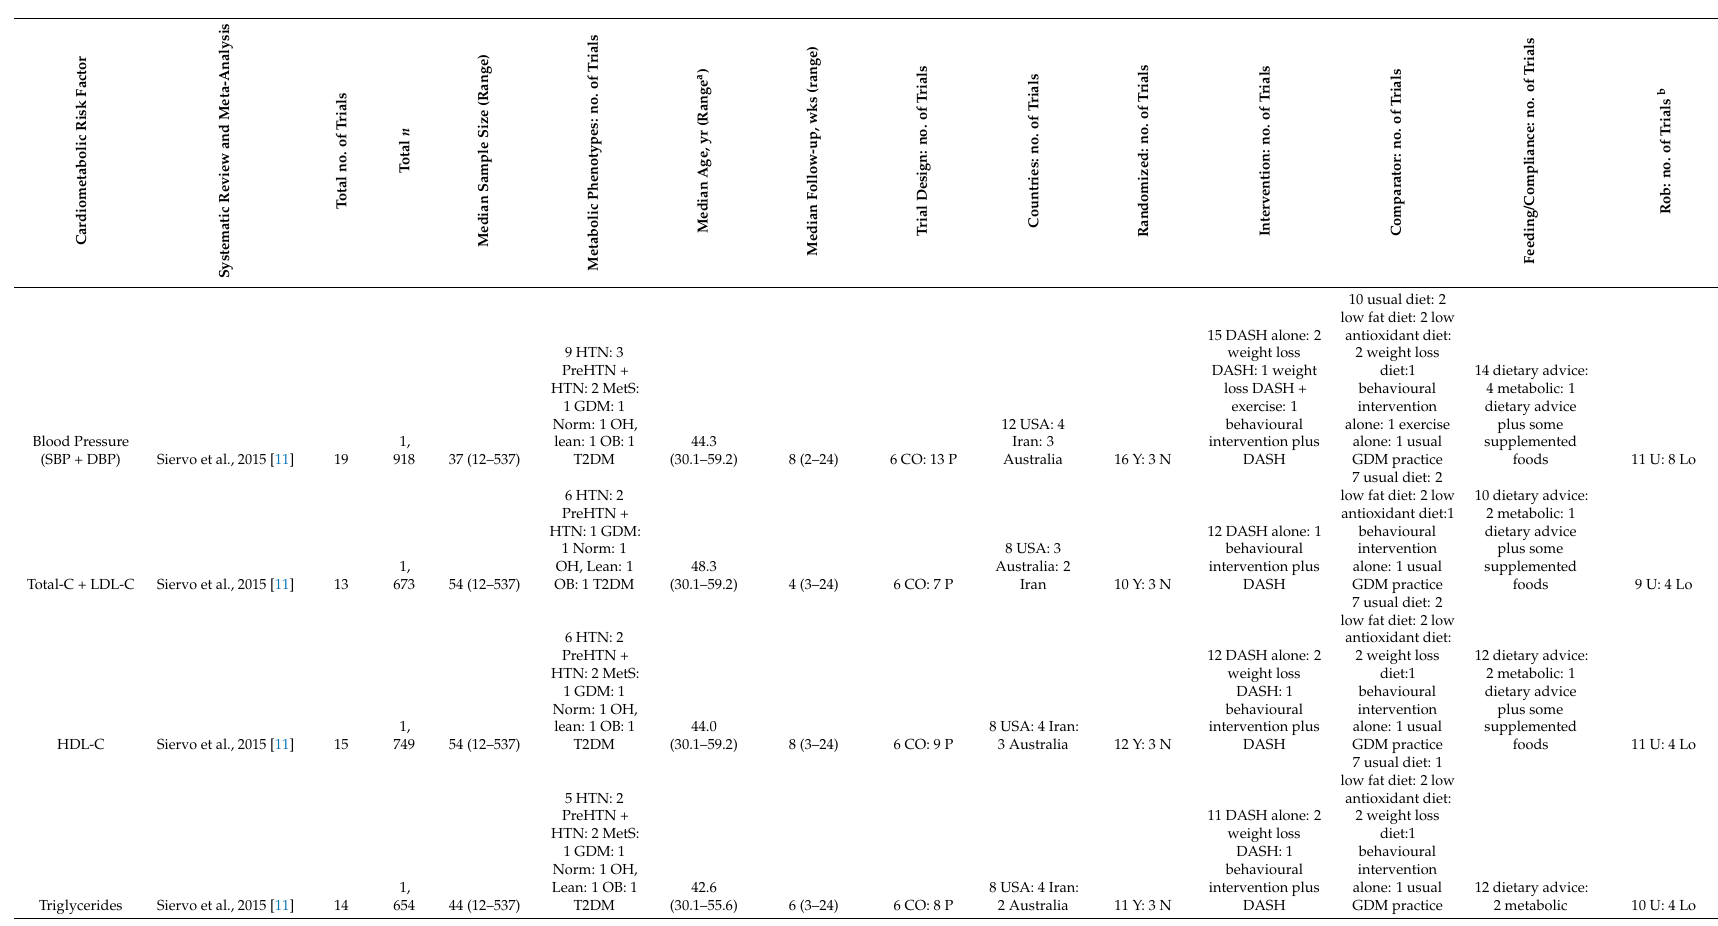
Table 2. Summary of characteristics of included trials in the most recent systematic reviews and meta-analyses of controlled trials assessing the effect of the DASH dietary pattern on cardiometabolic risk